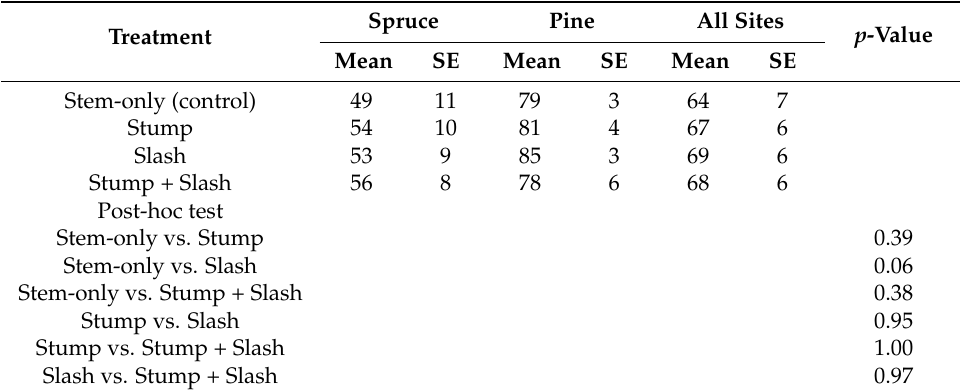
Table 4. Survival rates (%) after 5 years for seedlings planted after additional harvest of stumps, slash, both stumps and slash, relative to the control treatment where only the stem wood was harvested leaving stumps and slash behind.